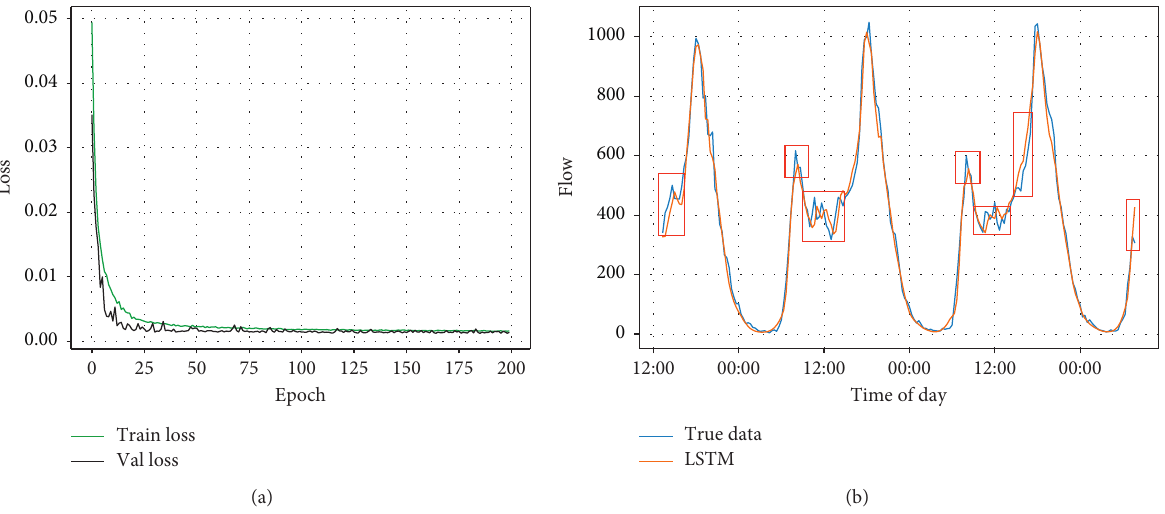
Figure 5: 20min LSTM training and prediction. (a) 20min LSTM loss function and (b) 20min LSTM prediction results.